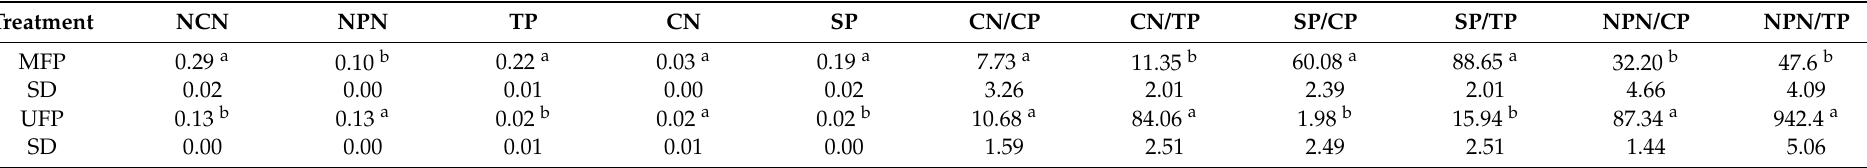
Table 4. Mean ( n = 3) permeate (MFP 1 and UFP 2 ) protein content and various protein ratios (% by weight) produced during a microfiltration and ultrafiltration of milk using polymeric spiral-wound membrane.